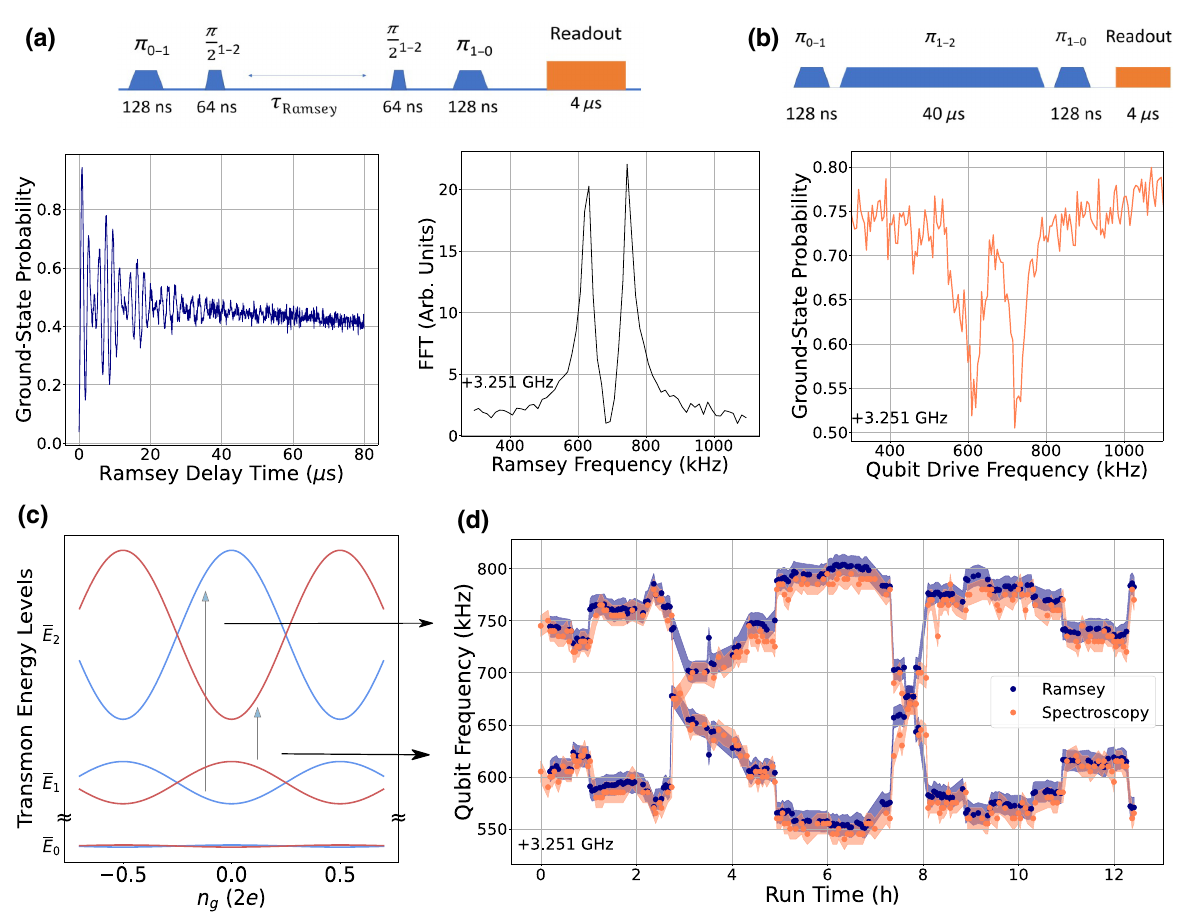
FIG. 2. Comparison between qubit spectroscopy and Ramsey measurements in higher levels. (a). Ramsey measurements in the 1-2 qudit subspace shows a beat frequency in its decay. A fast Fourier transform is applied to the measurement trace and the two frequencies corresponding to the two charge-parity state frequencies are revealed. (b). The high-precision qubit spectroscopy measurement in the 1-2 level uses a 40 μ s excitation pulse after being prepared in the qudit’s first excited state. The narrow bandwidth 1-2 excitation pulse allows the two charge-parity state frequencies to be resolved. (c). The energy-level diagram of the qudit’s excited states as a function of charge offset illustrates how the the two frequencies present in these measurements are due to the qudit being in either its even or odd charge-parity state. Note that the charge dispersion is not drawn to scale. (d). Taking interwoven qubit spectroscopy and Ramsey measurements over the course of 12 h show clear agreement between the two